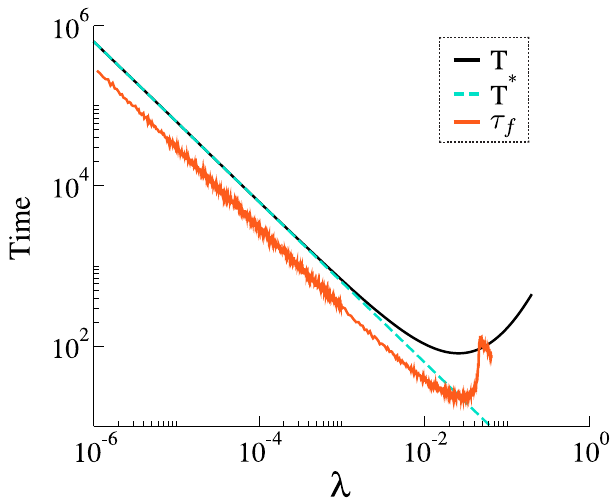
Fig. 8 Approximations T and T * for the time to reach the absorbing state as a function of λ . Results for δ = 1.0 and α = 0.5. The orange curve is the result of Monte Carlo simulations in a random regular network with the same parameters, 〈 k 〉 k = 10 and N = 10 5